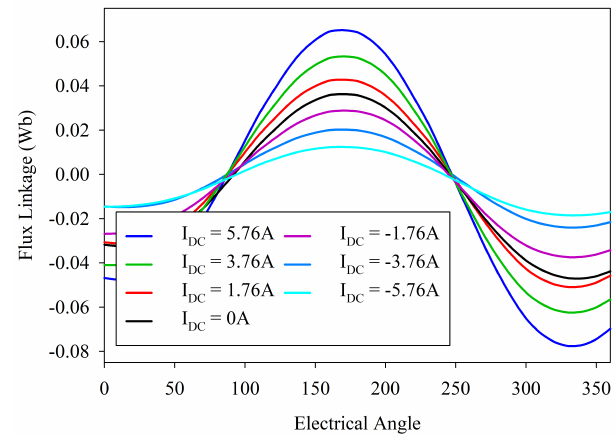
Figure 12. Flux regulation capability of the proposed machine.